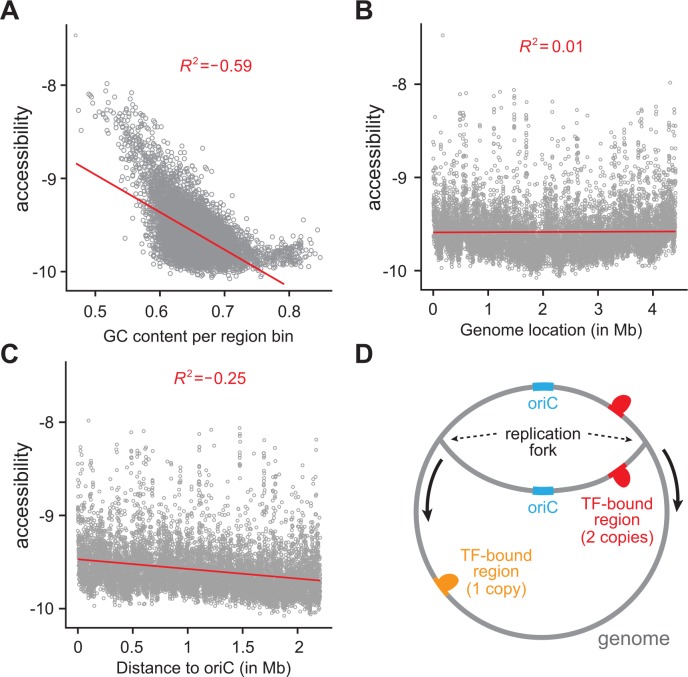
Genome accessibility is affected by GC content and distance to oriC.(A) Accessibility is negatively correlated with local genomic GC content. The correlation between accessibility values and region GC content after controlling for values of motif affinity is -0.30 (p < 10−179; function pcor and pcor.test, R package ggm). (B) Accessibility does not appear to correlate with genome position. (C) Accessibility is negatively correlated with distance to oriC. (D) A schematic of genome replication that could explain the correlation between accessibility and distance to origin of replication.